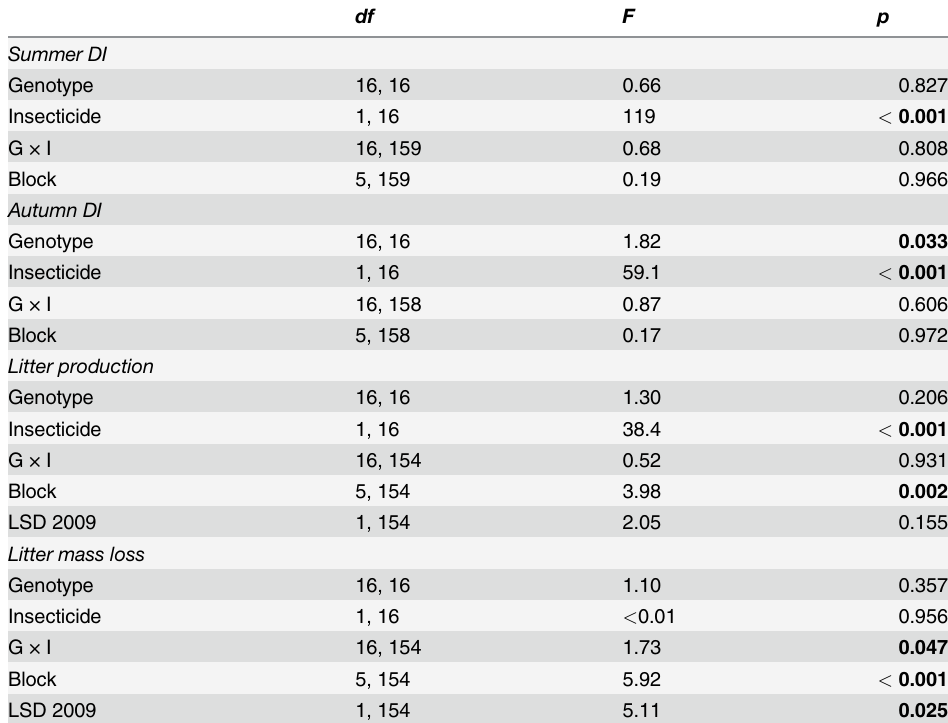
Table 1. The ANOVA table of the effects of genotype and insecticide on B. pendula insect herbivore damage index, litter production and litter mass loss. df F